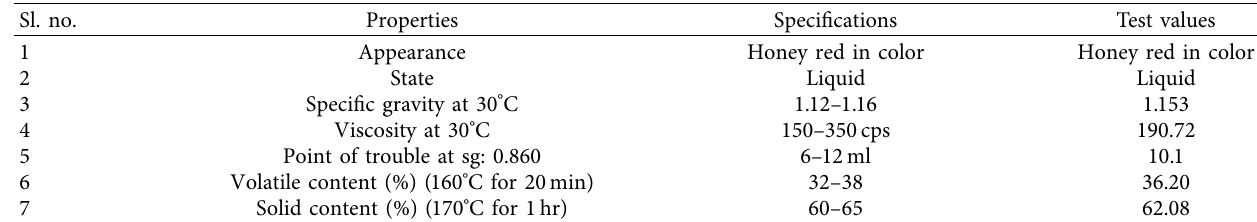
Figure 1: (a) Schematic of workflow. (b) Detail process flowchart for nano-C-Ph composite laminate fabrication. Table 1: Resol phenolic resin specifications. Sl.